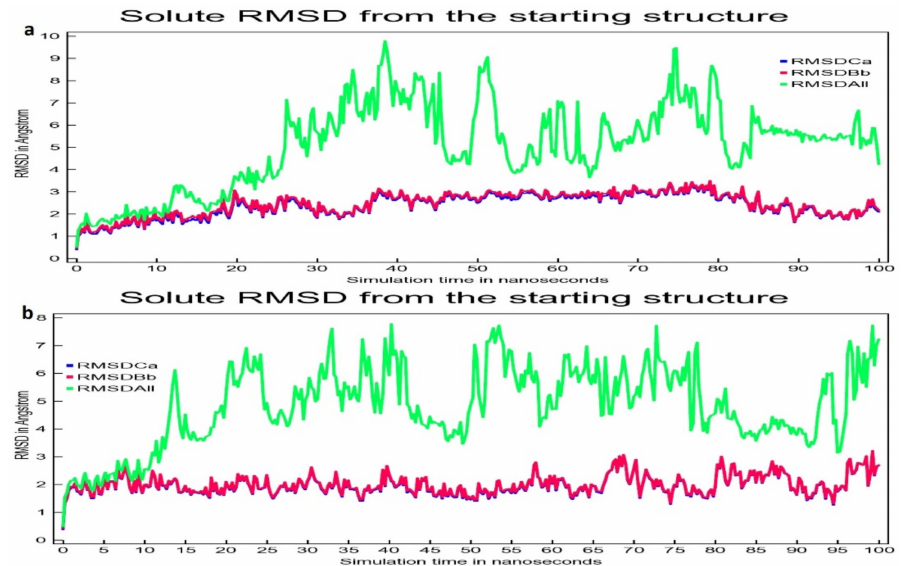
Figure 4. Solute root mean square deviation (RMSD) for ( a ) DTQ-3CLpro complex ( b ) DTQ-NSP15 complex versus simulation time of 100